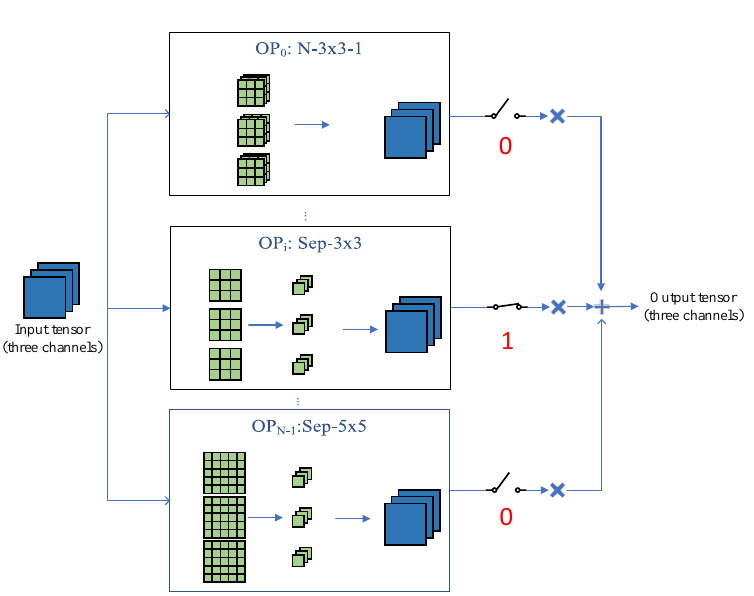
Figure 2. Illustration of the searching stage. In the searching stage, the mask of each branch OH can be simultaneously learned with the parameters of convolutional operators. If OH α l ( i ) = 0 in the current training step, it means the i th branch does not work at this moment, and vice versa. The reconstructed CNN is equivalent to the child CNN formed by the branches whose mask is 1 in each training